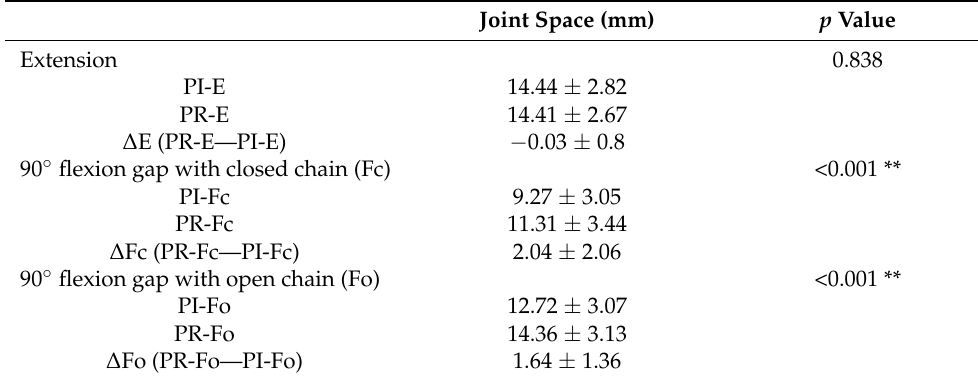
Table 2. The gap space changes before and after PCL resection.